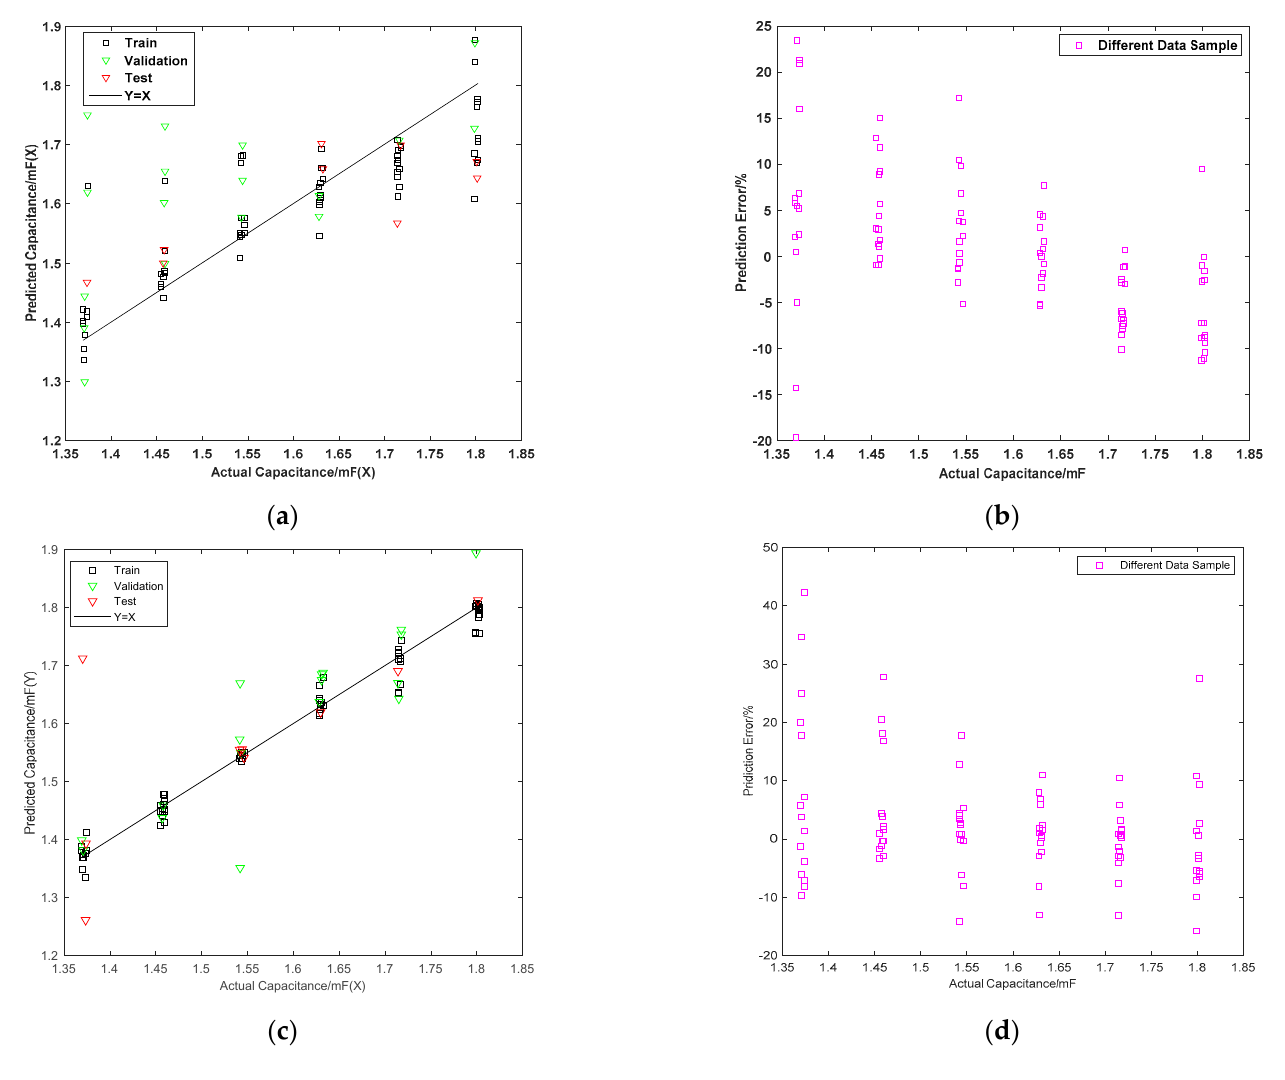
Figure 11. ESR estimation results under experiments by ANN when N ESR = 10 ( a ) a best fitting showing train, test and validation results; ( b ) cross validation showing PEs for 10 fittings under 10 random data divisions.